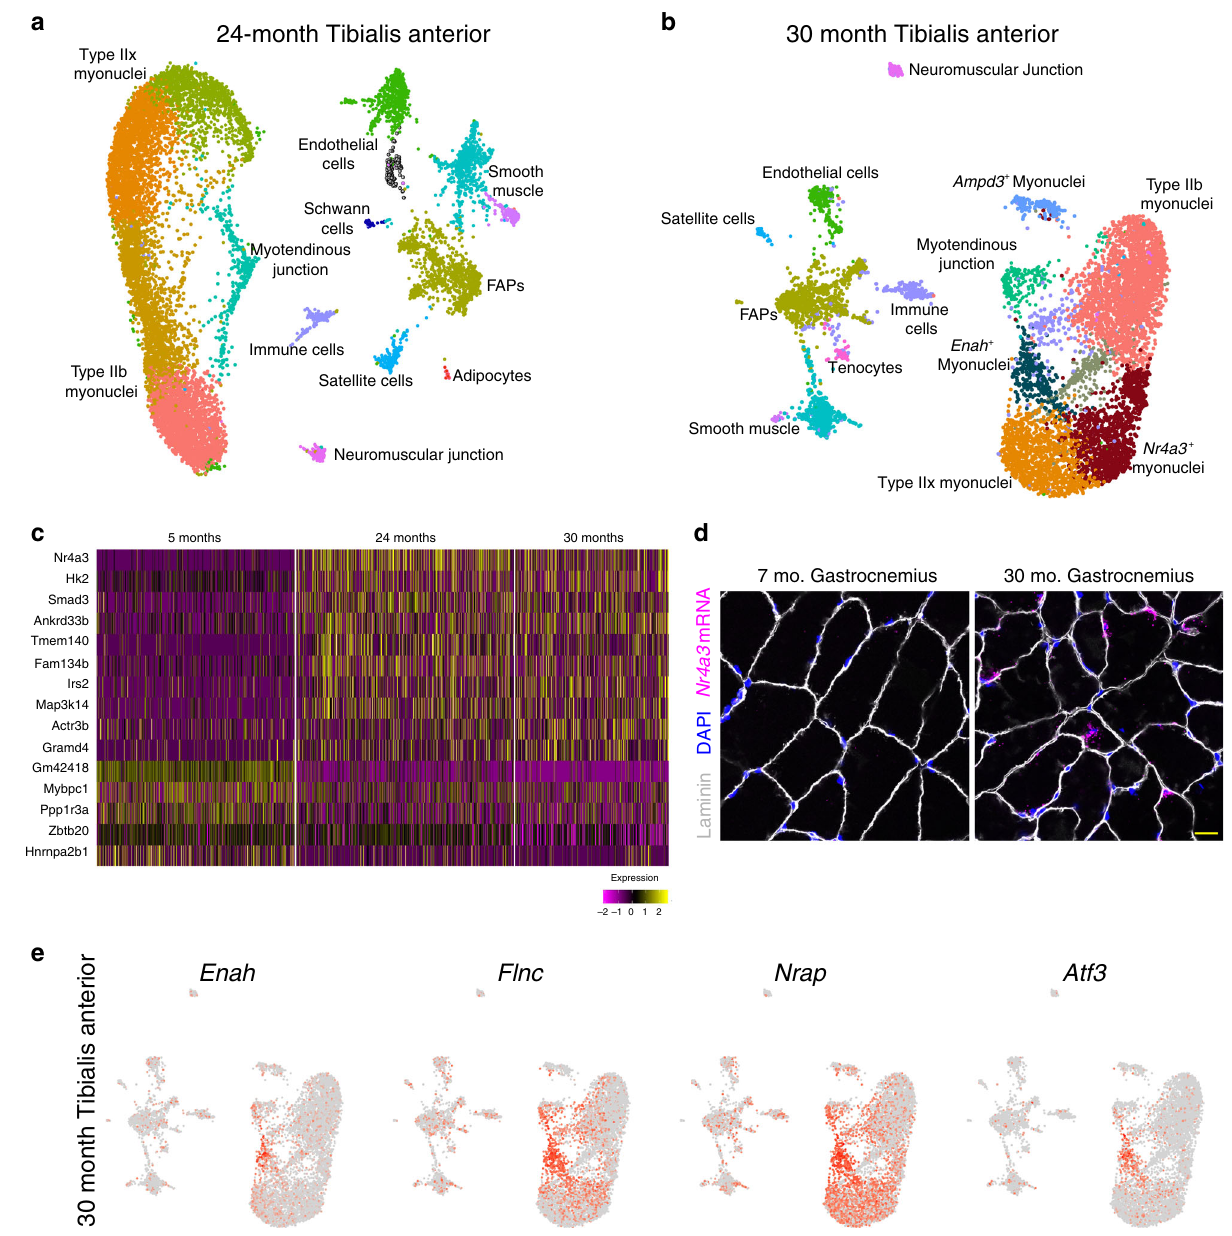
Fig. 4 Uniform gene expression between myonuclei is disrupted in aged muscle. a UMAP of snRNA-seq data from the tibialis anterior of a 24-month-old mouse displaying similar clusters as at 5 months of age. b UMAP of snRNA-seq data from 30-month-old muscle displaying the presence of unique clusters of myonuclei marked by Ampd3, Enah , and Nr4a3 . c Heatmap of integrated myonuclei from 5, 24, and 30-month tibialis anterior muscle showing a consistent transcriptional signature of aging muscle. Columns are individual nuclei belonging to each to timepoint. d Representative image of smRNA-FISH for Nr4a3 validated its upregulation in myonuclei in 30-month skeletal muscle ( n = 3 for each group). Scale bar: 10 μ m. e Feature plots of key marker genes of the Enah + population within 30-month